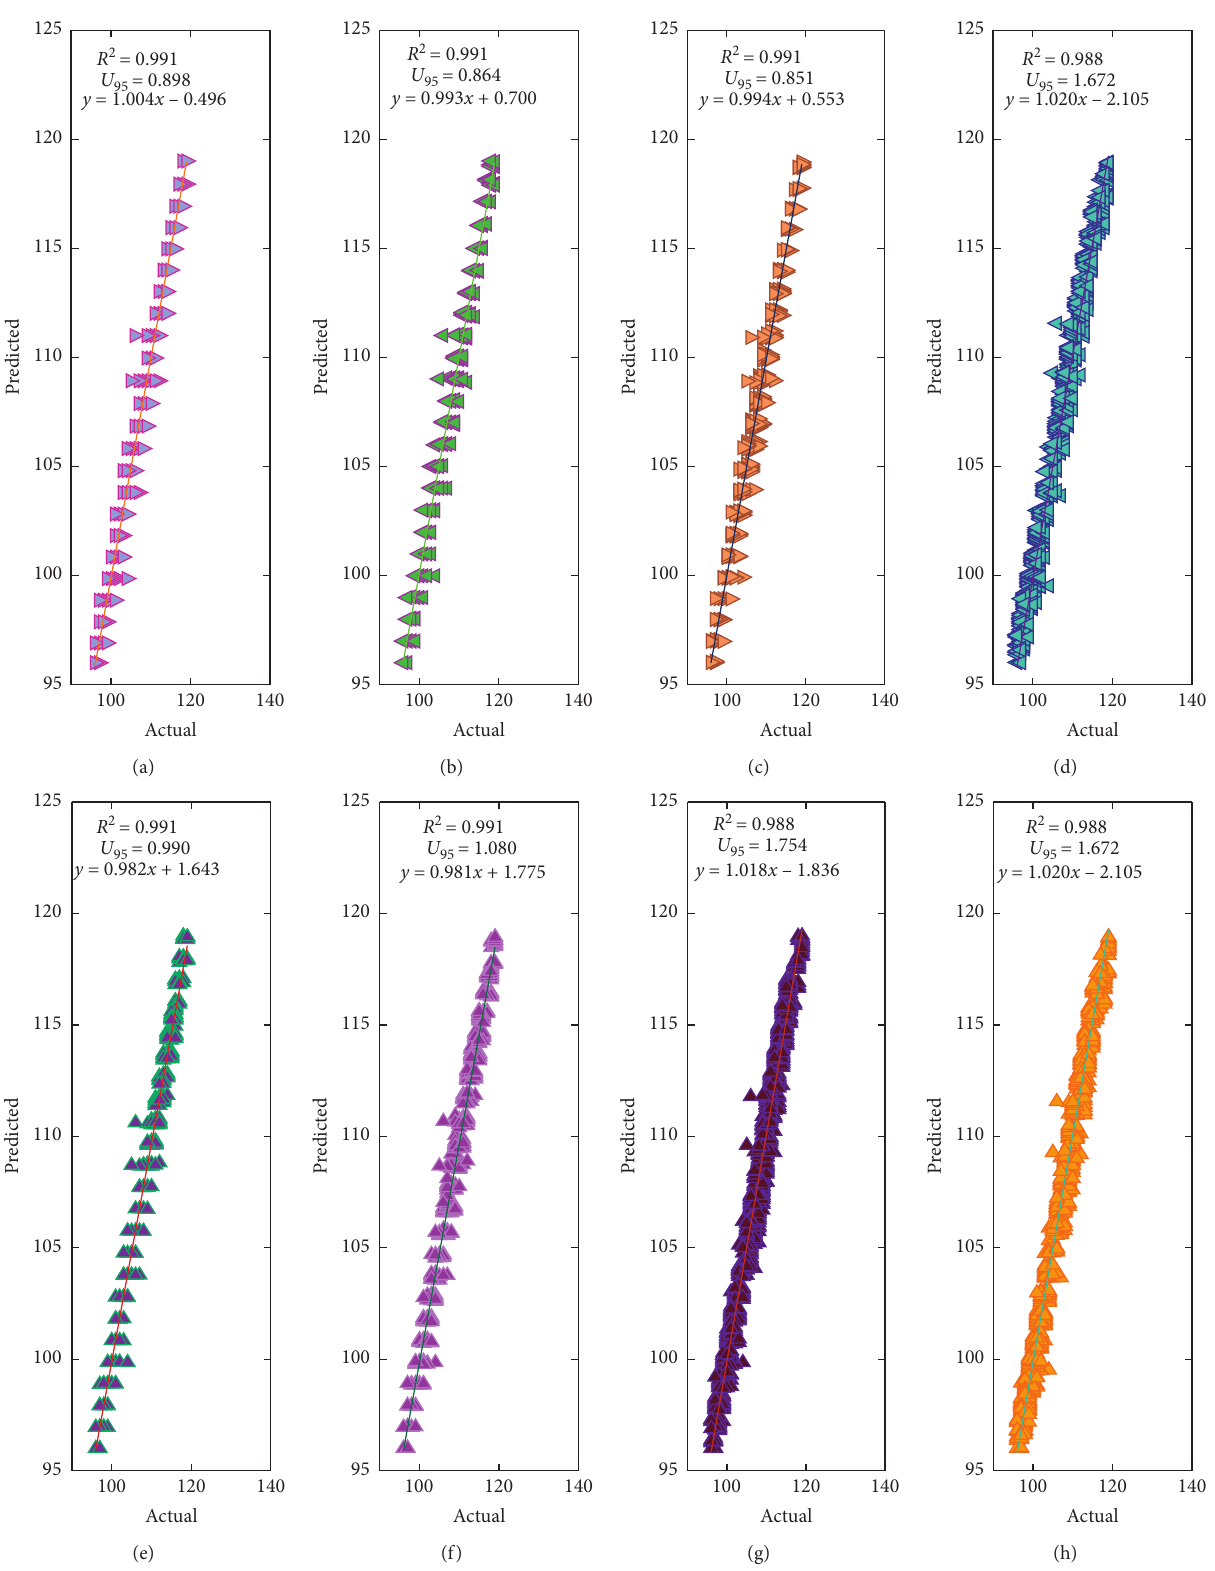
Figure 10: ELM models for USGS 14150000 station: coefficient of determination. (a) ELM-M1. (b) ELM-M2. (c) ELM-M3. (d) ELM-M4. (e) ELM-M5. (f) ELM-M6. (g) ELM-M7. (h)